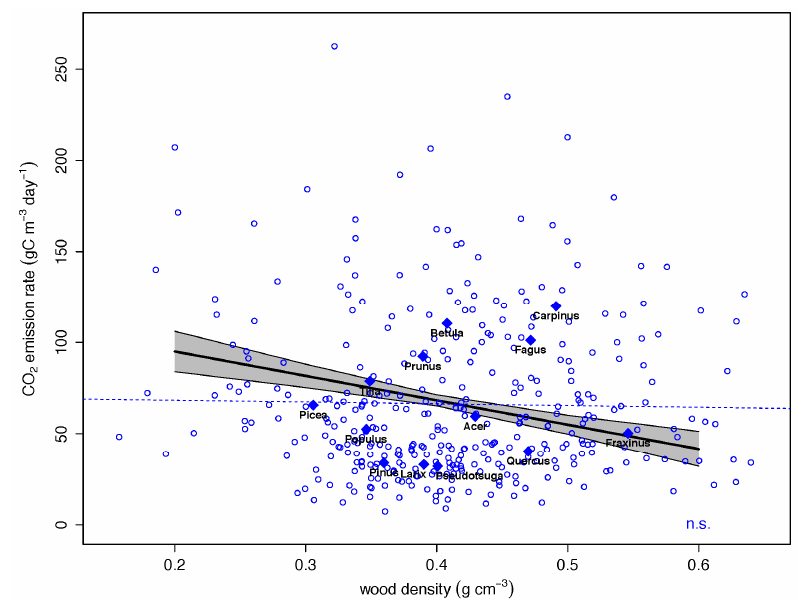
Figure 5. Relationship between CO 2 emission rates and the significant explanatory variable wood density for the best-fit global model. Solid regression line and the surrounding grey 95% confidence interval shows the significant main effect and is corrected for the influence of the other variables in the best-fit global model. The blue data points represent field observations from 355 logs. The blue dashed regression line represents the linear correlation based on the field observation data. Blue diamonds represent mean field observation values by tree